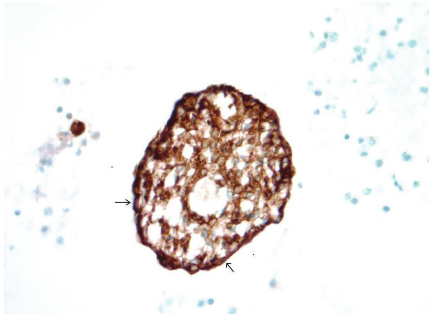
Figure 6: The “floating island” pattern of hepatocellular carcinoma. This image is used to illustrate the unique tumoral growth pattern of cohesive sheets of lesional epithelial cells that are intimately invested by a delicate outer layer of flattened endothelial cells. Arrows mark some of the peripheral wrapping endothelial cell nuclei (cell block, hematoxylin and eosin stain, 400x). This photomicrograph comes from a metastatic moderately differentiated hepatocellular carcinoma in a 64-year-old female and is not from the index patient in the current case report. It is presented for comparison as an example of a morphologic differential diagnosis with some overlapping features with the current unique example of metastatic DSRCT.